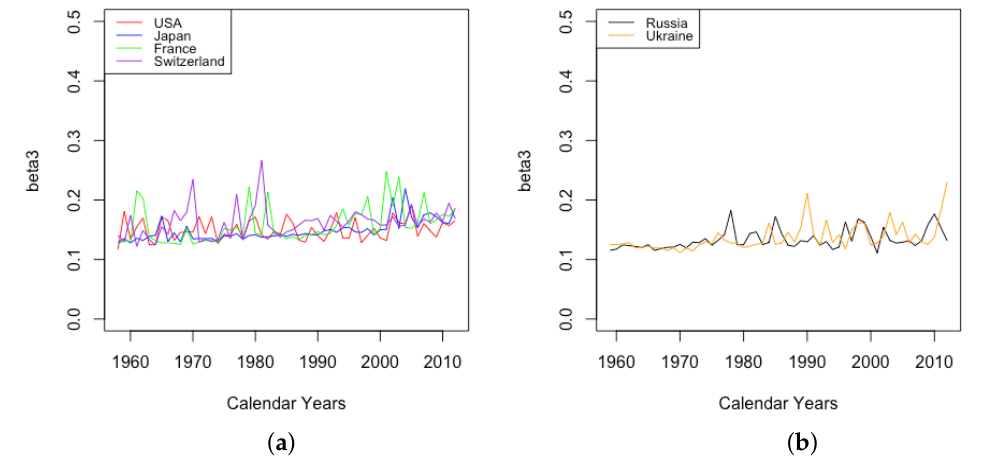
Figure 12. ( a ) Level β 3 of the mortality acceleration factor at old ages across HLE countries. ( b ) Level β 3 of the mortality acceleration factor at old ages across ILE